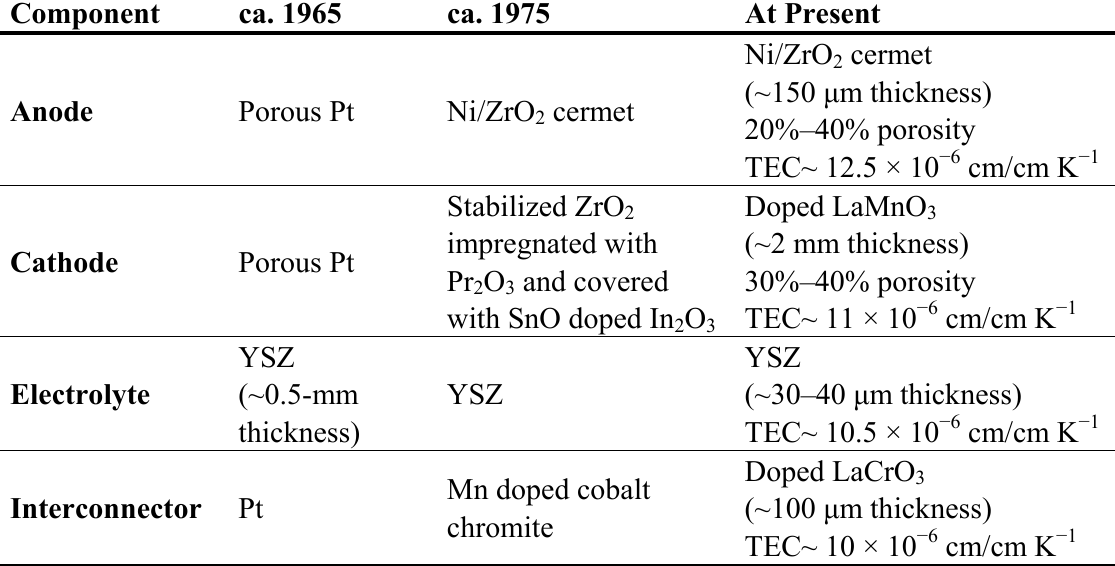
Table 1. Evolution of cell components for tubular SOFCs (adapted from reference [1]).